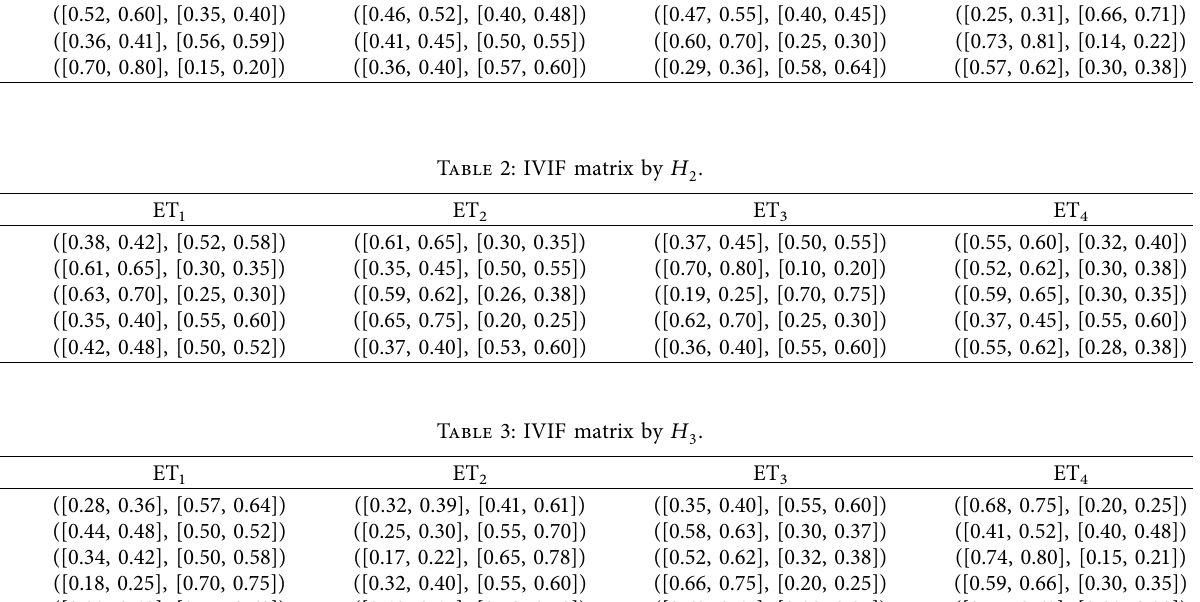
Table 1: IVIF matrix by H